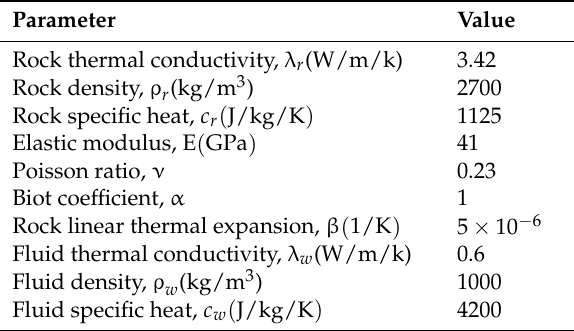
Table 2. Parameters of rock and fluid.